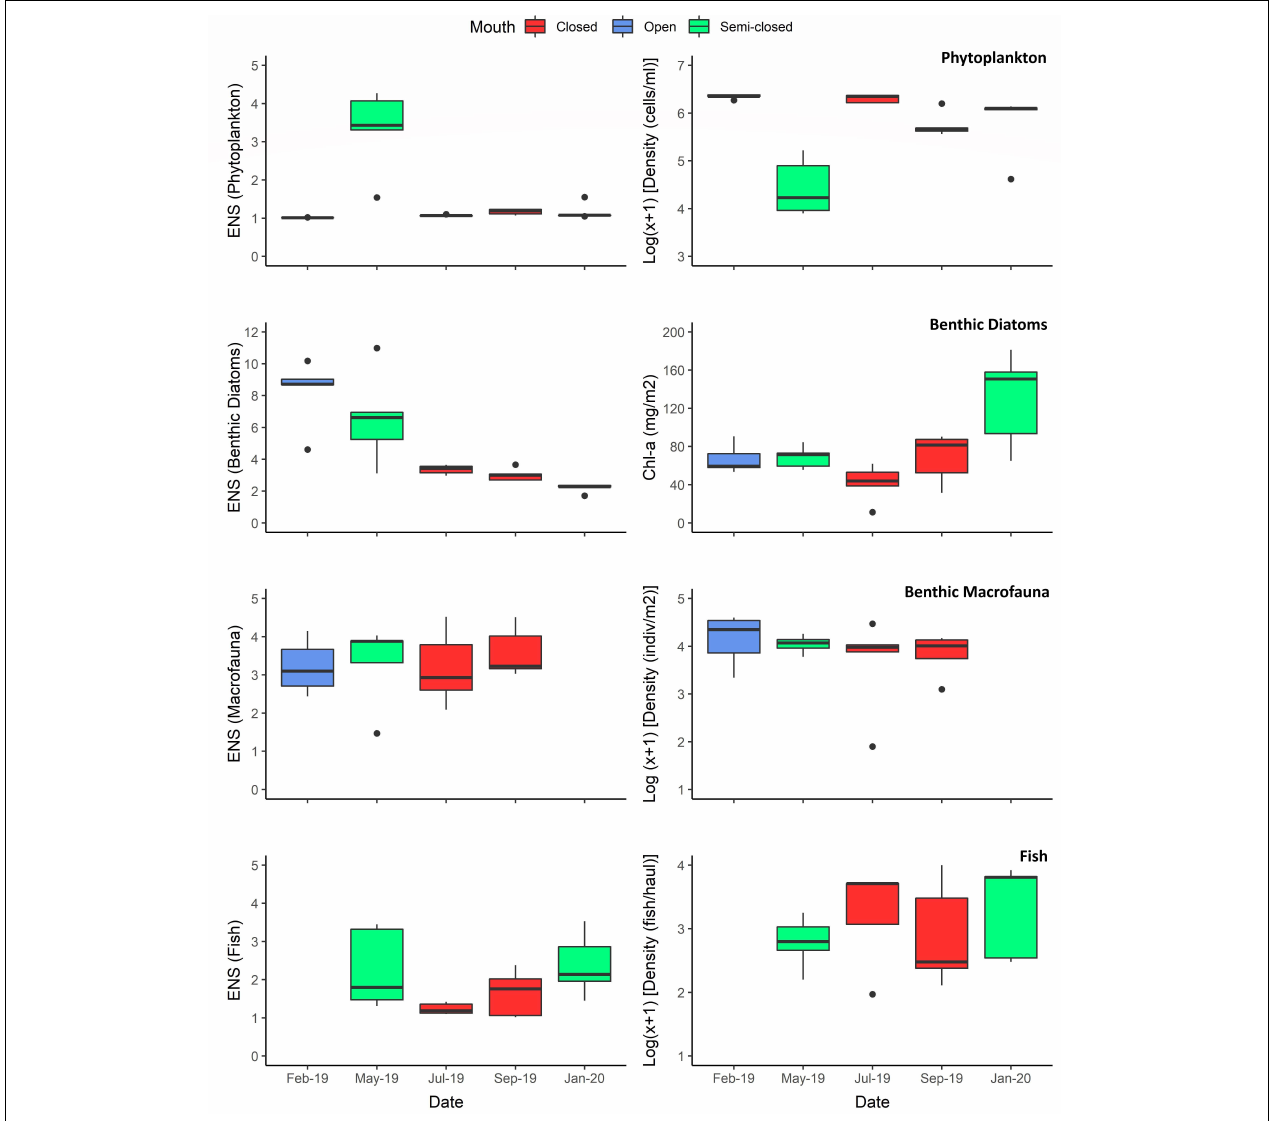
FIGURE 4 | The effective number of species (ENS) for each of the biotic communities–per sampling date–is indicated in the left-hand column, while a quantitative measure for each of these communities is presented in the right-hand column, i.e., phytoplankton (cells per ml), benthic diatoms (microphytobenthic chlorophyll- a ), benthic macrofauna (individuals per m 2 ), and ichthyofauna (fish per haul). The degree of estuary connectivity with the marine environment on each sampling date is indicated, i.e., open (blue), semi-closed (green), and closed (red) mouth conditions. Boxplots represent median values (solid line), interquartile range (IQR = 25th